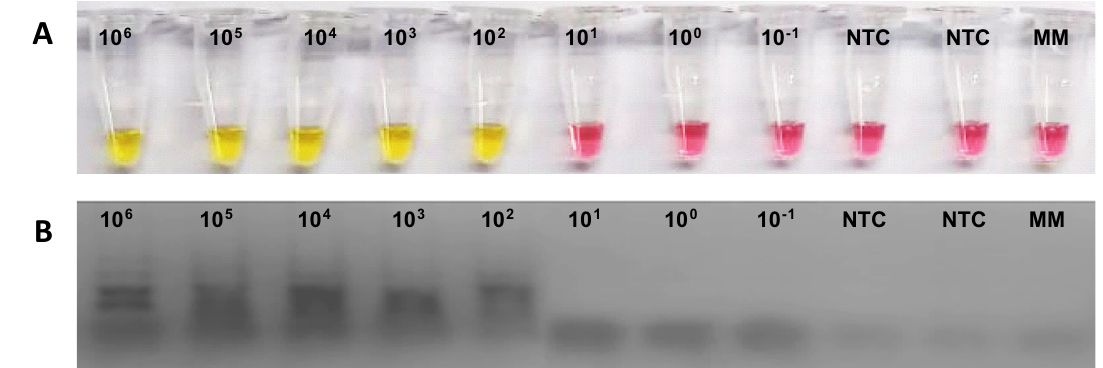
Figure 2. ( A ) Limit of detection of 2019-nCoV_RdRp positive control RT-LAMP. ( B ) Products of RT LAMP in agarose gel match the detection limit.